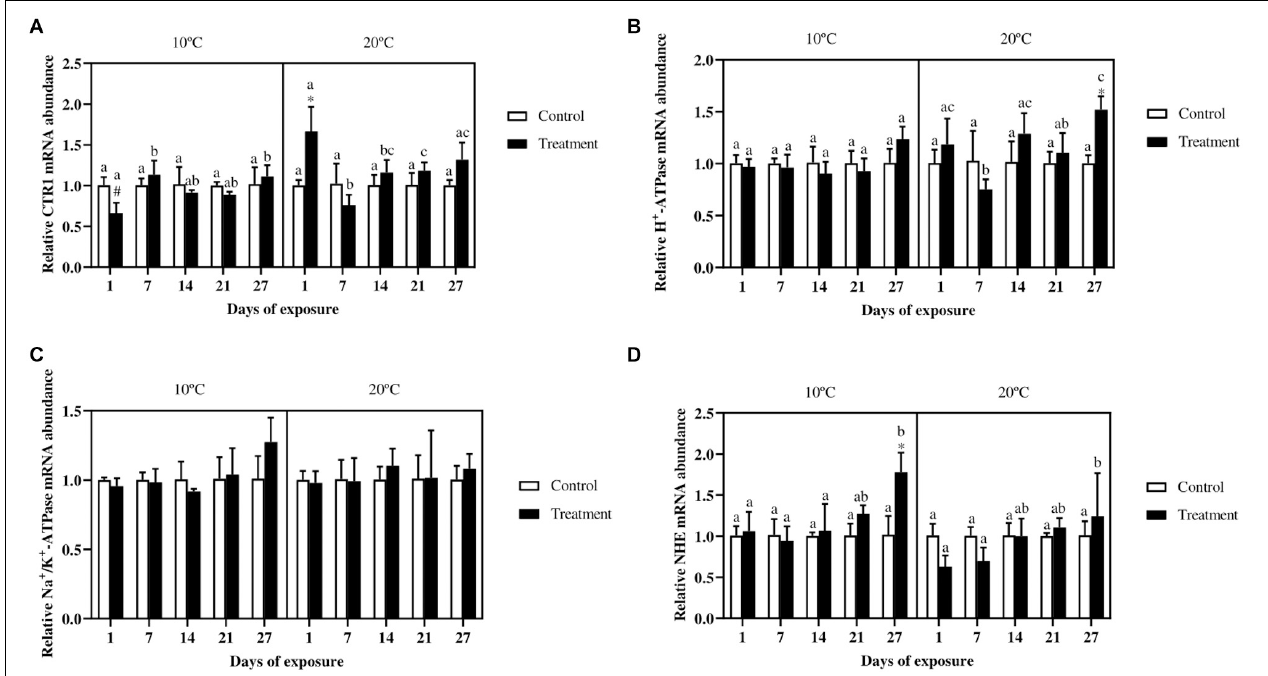
FIGURE 5 | Relative copper transporter 1 (A) , H + -ATPase (B) , Na + /K + -ATPase (C) , and Na + /H + -exchanger (D) mRNA abundance in gills of Cyprinus carpio exposed to Cu, Zn, and Cd mixtures for 27 days. Mean ± SD, N = 4. Asterisks (*) indicate differences between control and metal treatment at each sampling day, the hash (#) indicate differences between the same groups (both control and metal treated) at different temperatures, and lowercase letters indicate significant differences of the same group among sampling days at each temperature ( p <